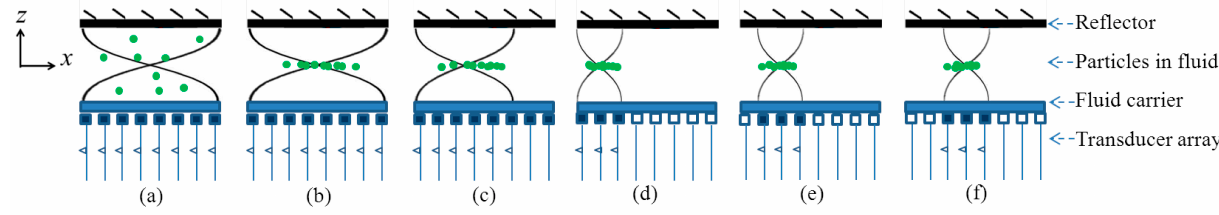
Figure 7. USM with a transducer array integrated into a multilayer resonator: ( a ) USW generated between an US transducer array and a reflector; ( b ) particles in fluid layer move towards pressure nodal plane; ( c, d ) reducing the number of active elements of the array, lateral acoustic energy density gradients move particles above the middle of the active elements; ( e, f ) selecting other active elements moves trapped particles along fluid